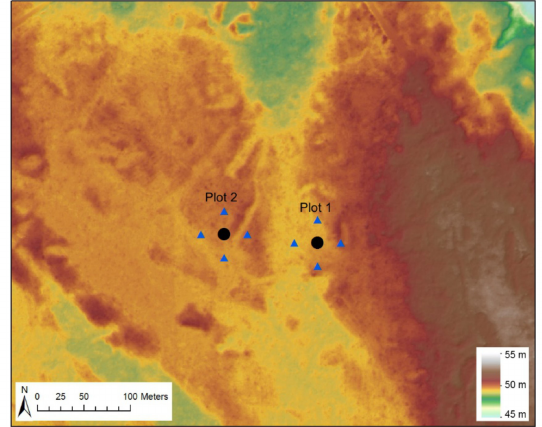
Figure 2. Digital Elevation Model (DEM) of the study area. The DEM was generated using data from a high spatial resolution airborne LiDAR survey in 2011 and shows the height above sea level for each square meter of the study area. The black circles depict the tower locations of plot 1 and plot 2. The blue triangles represent groundwater pipes installed down to 2.5 m depth, 25 m North, East, South and West of each